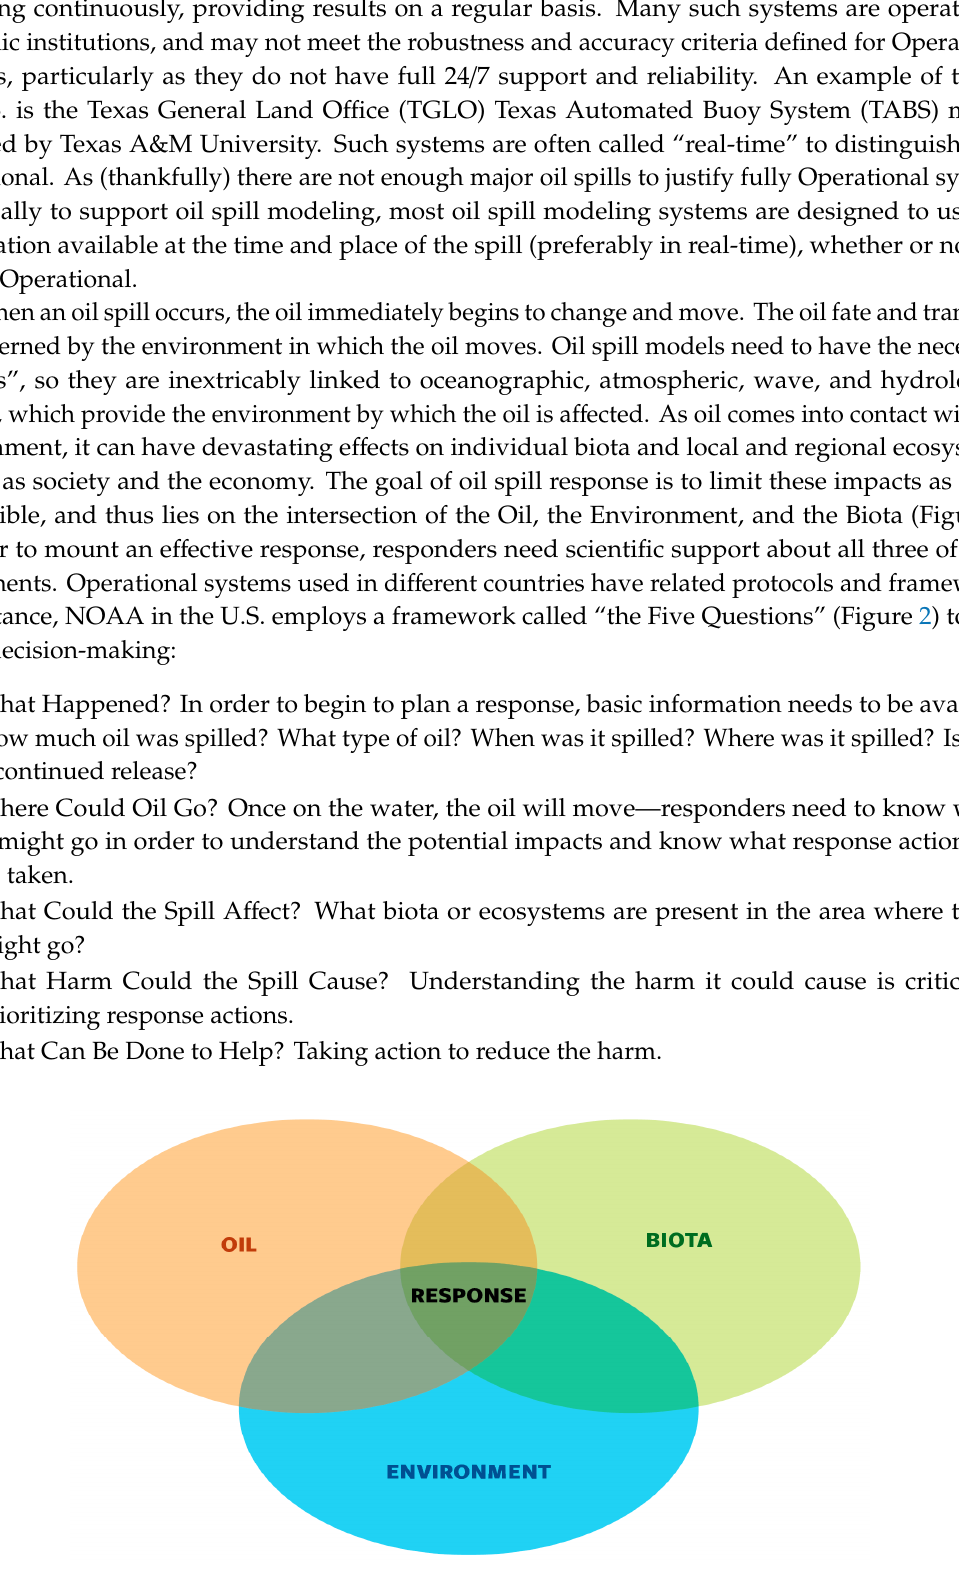
Figure 1. Spill response works at the intersection of the Oil, the Environment, and the Biota.